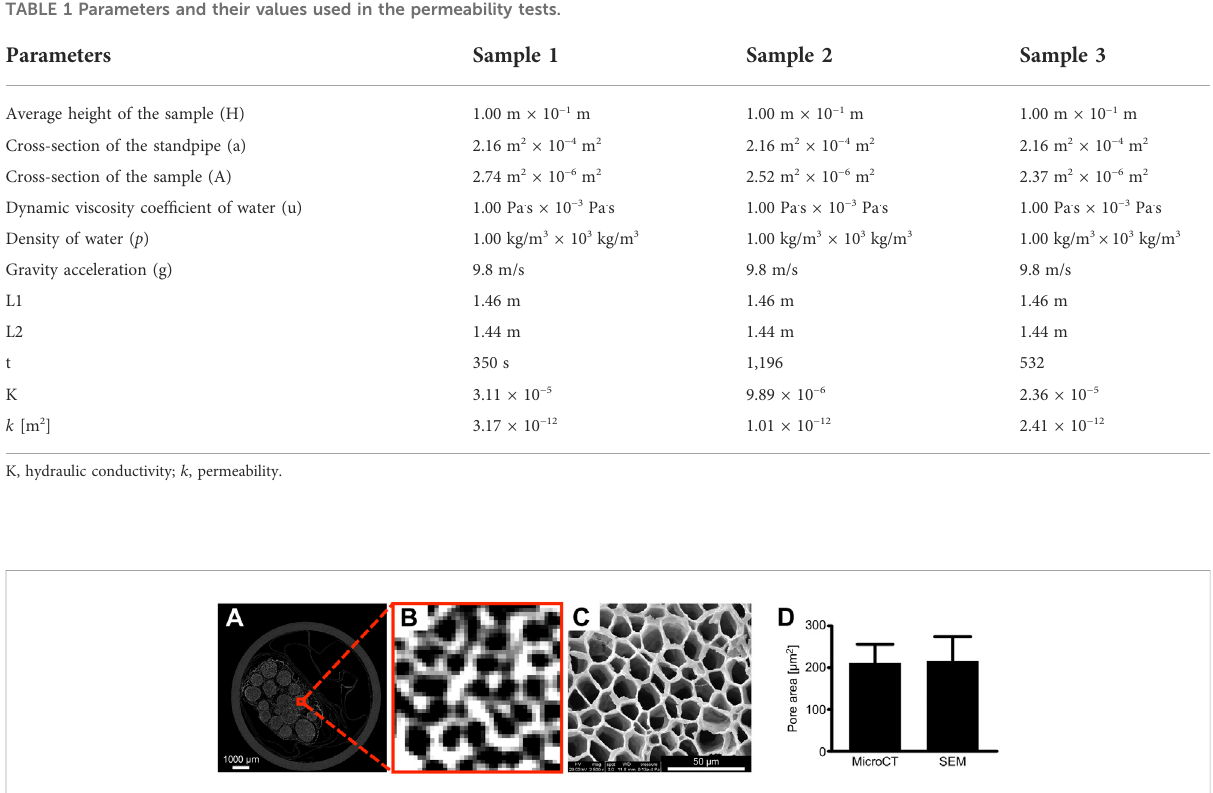
TABLE 1 Parameters and their values used in the permeability tests.